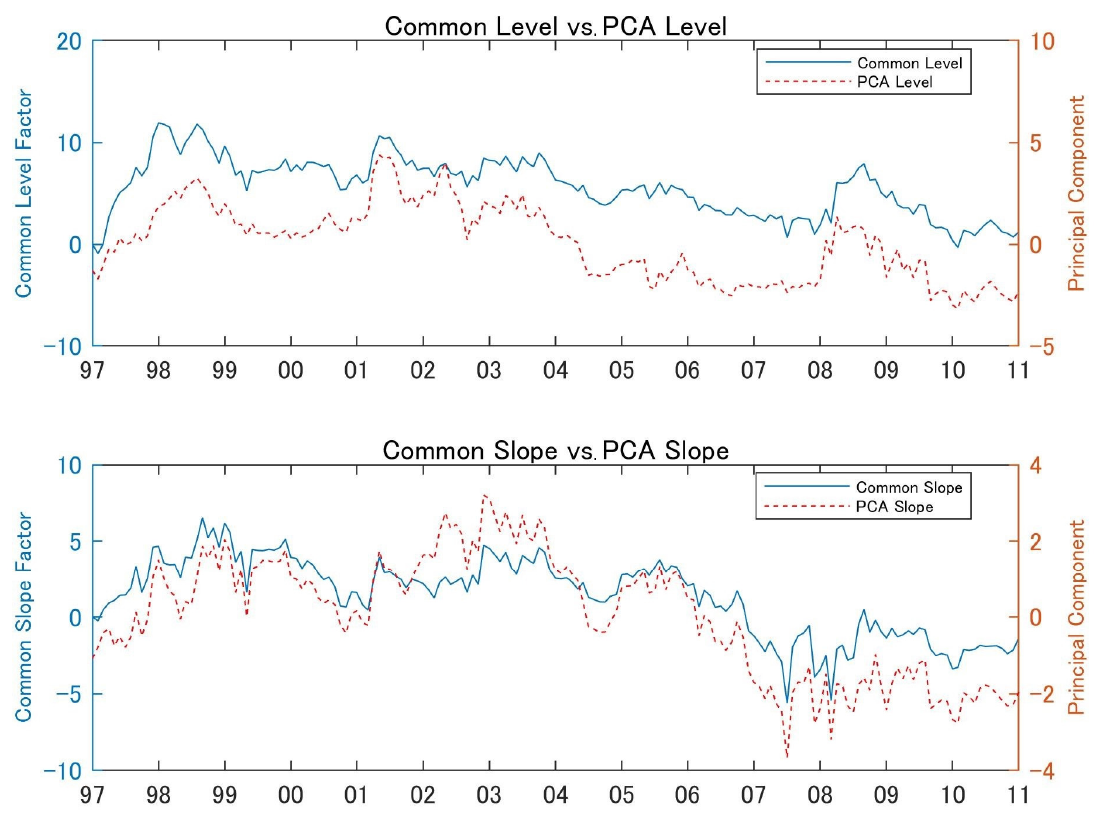
Figure 3. Common factor vs. PC1 of firm level and slope. Note: The estimated common factor is indicated by a solid line and PC1 by a dashed line.